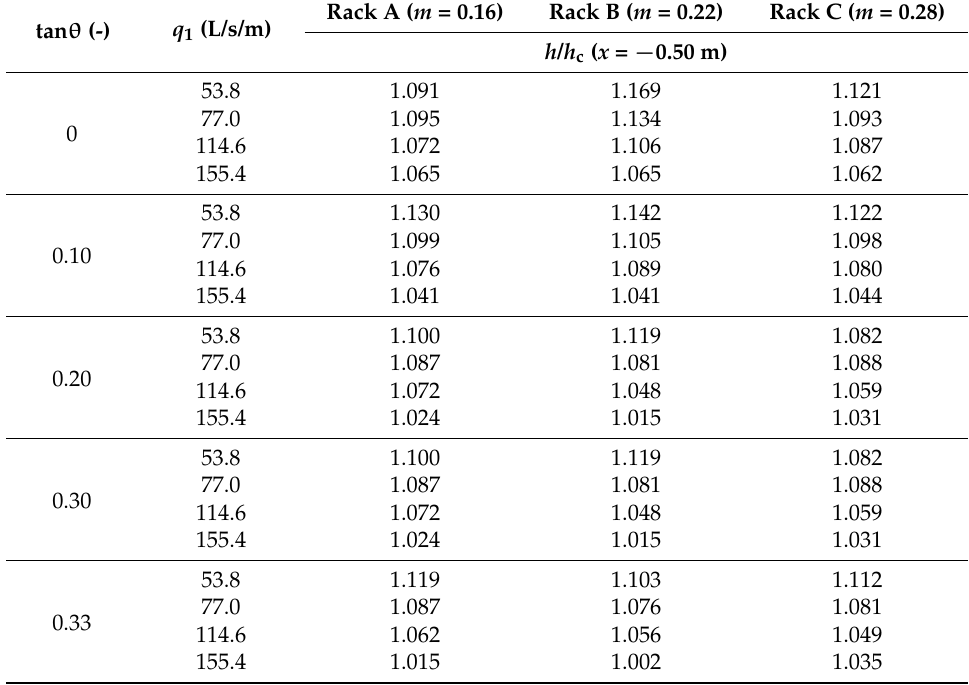
Table 3. Approaching flow depth related to critical depth at x = − 0.50 m upstream of the rack. Rack A ( m = tan θ (-) q 1 (L/s/m)